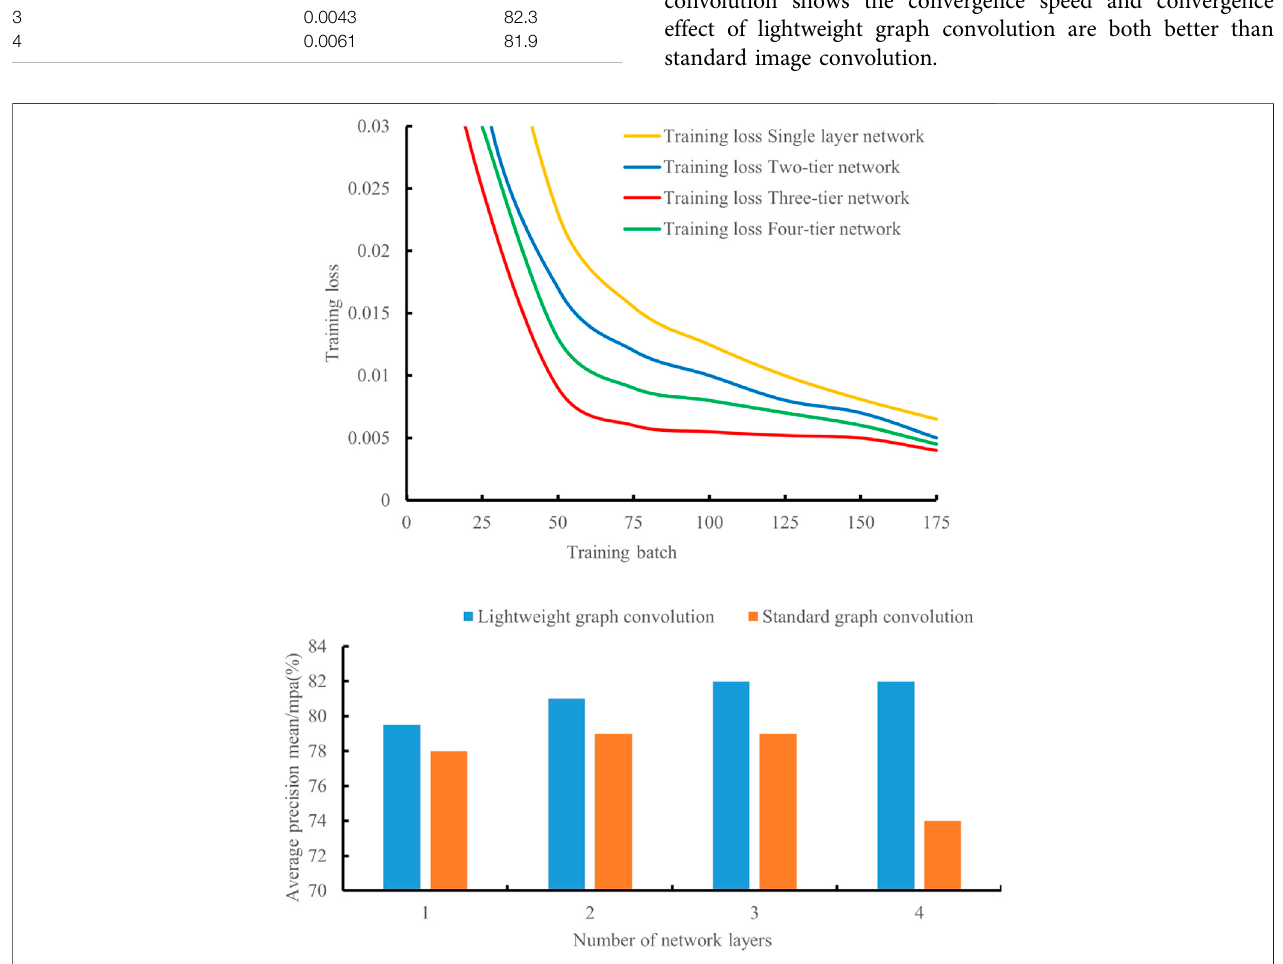
FIGURE 7 | Comparison of graph convolutions with different